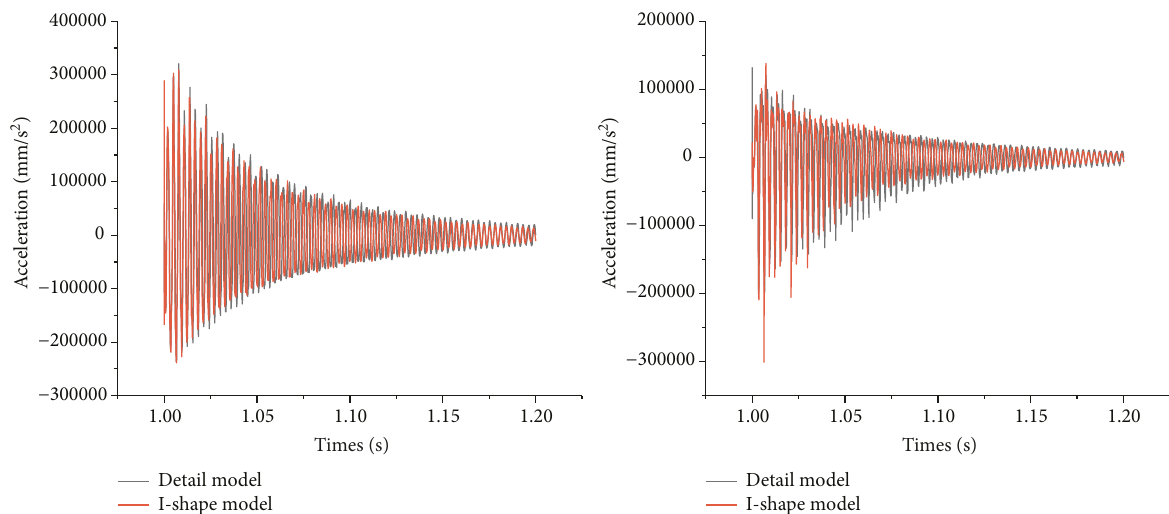
Figure 11: X and Y direction acceleration response (at the outer wall of the flange under 1.5 kN impact load on the top).